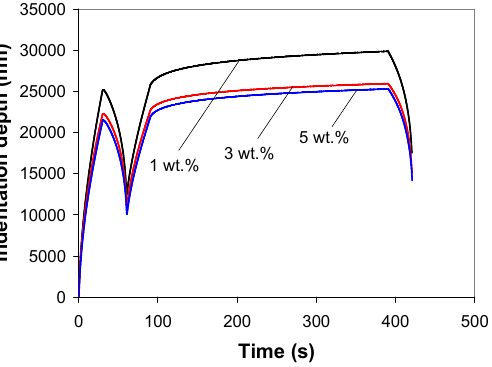
Figure 6. Displacement-time curves from 2-cycle indentation on the PP / MWCNT nanocomposites at 2000 N / min loading / unloading rate and 300 s holding time.